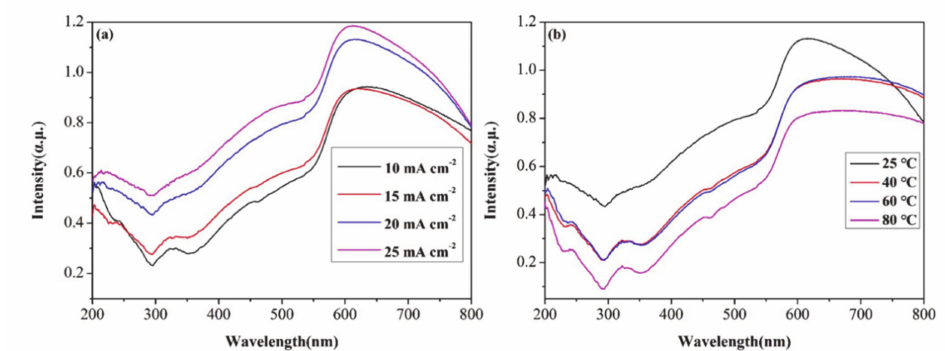
Figure 4. UV-vis absorption spectra of CuO / Cu foam synthesized with di ff erent conditions, di ff erent current density ( a ), and di ff erent anodizing temperature at 20 mA cm − 2 ( b